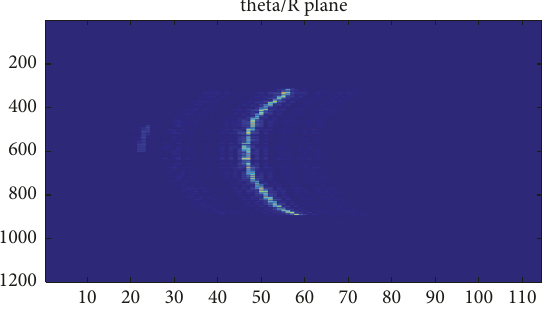
Figure 14: Angle-range